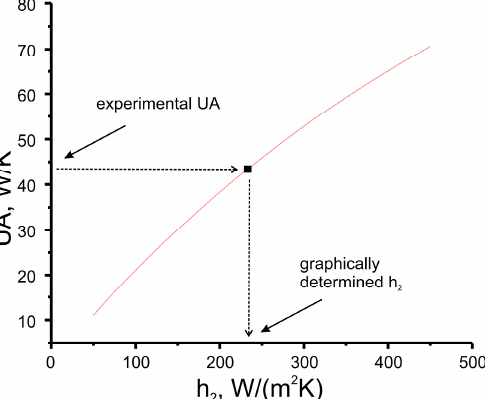
Figure A4. Dependence of global heat transfer coefficient UA of radiator R4 on heat transfer coefficient h 2 (red line) and element of experimental dataset (symbol). Arrows illustrate the principle of graphical solving of h 2 = function − 1 (UA).